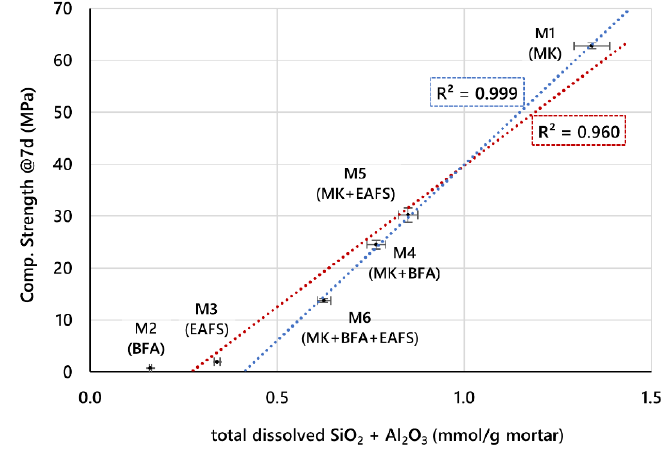
Figure 9. Correlation between CS of GPC mortars and total estimated dissolved aluminosilicates based on alkaline dissolution tests of precursors.